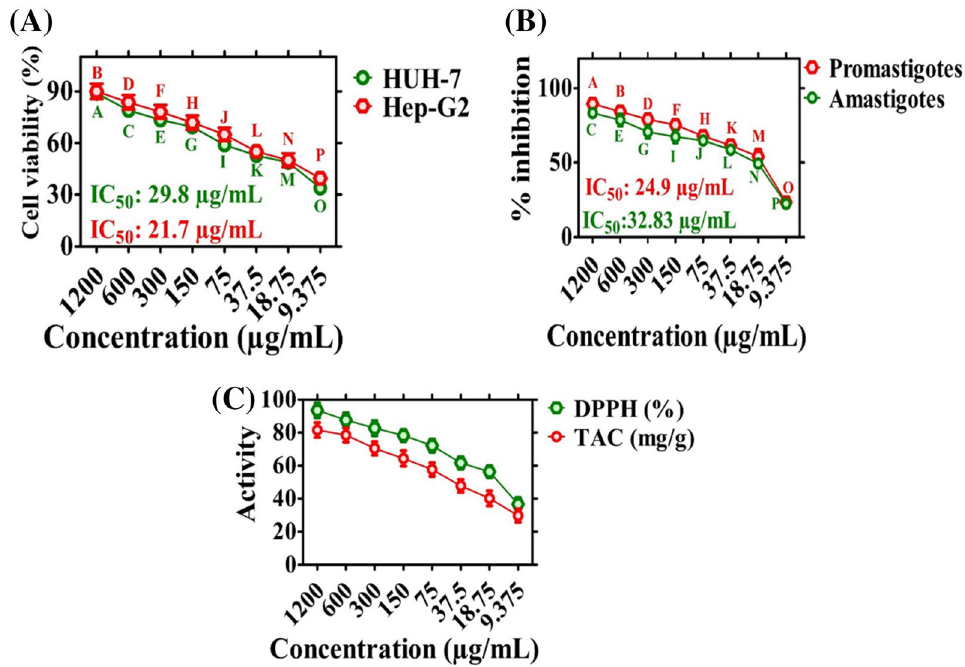
Figure 7. Anticancer, Antileishmanial and Antioxidant properties of ZnONPs. Data represents the mean of three replicates and each letter indicates significance at P < 0.05. All means in the data are significantly different from one another. ( a ) Anticancer potentials of ZnONPs against HUH-7 and HepG2; ( b ) antileishmanial potencies of ZnONPs; ( c ) antioxidant potential of ZnONPs Data represents the mean of three